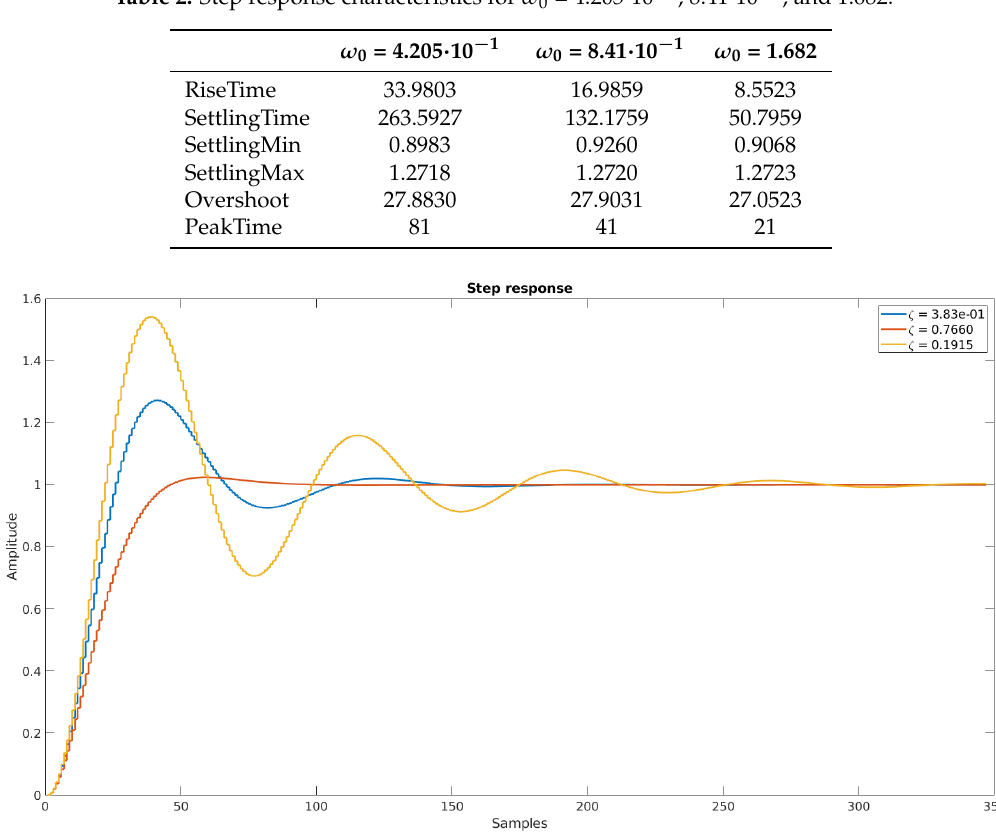
Figure 5. Comparison of the digital oscillatory system with ζ = 1.915 · 10 − 1 (orange), 3.83 · 10 − 1 (blue), and 7.66 · 10 − 1 (red); ω 0 =8.41 · 10 − 1 ; k = 1; and t s = 1/10